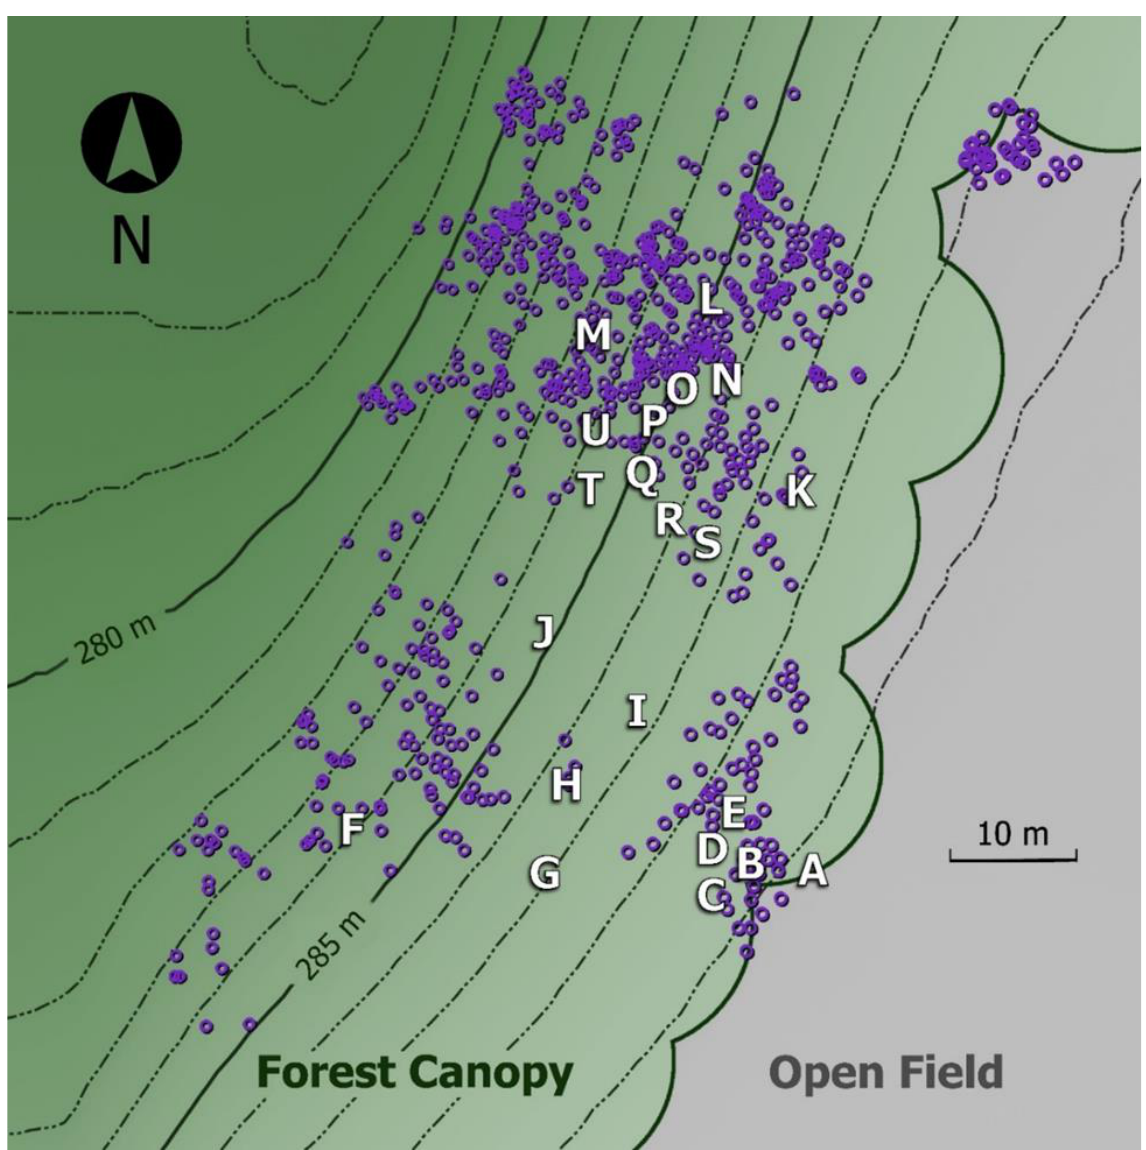
Figure 2. Map of the study site within Pammel Woods from N 42° 1' 55.0642" to N 42° 1' 51.5928" and W 93° 39' 7.7369" to W 93° 39' 14.6477" with elevation and scale denoted. Mature culms of D . obovata are indicated by purple rings and pollen trap stations are labelled with white letters. Forest canopy is represented with a green layer, while open canopy of the adjacent field is colored